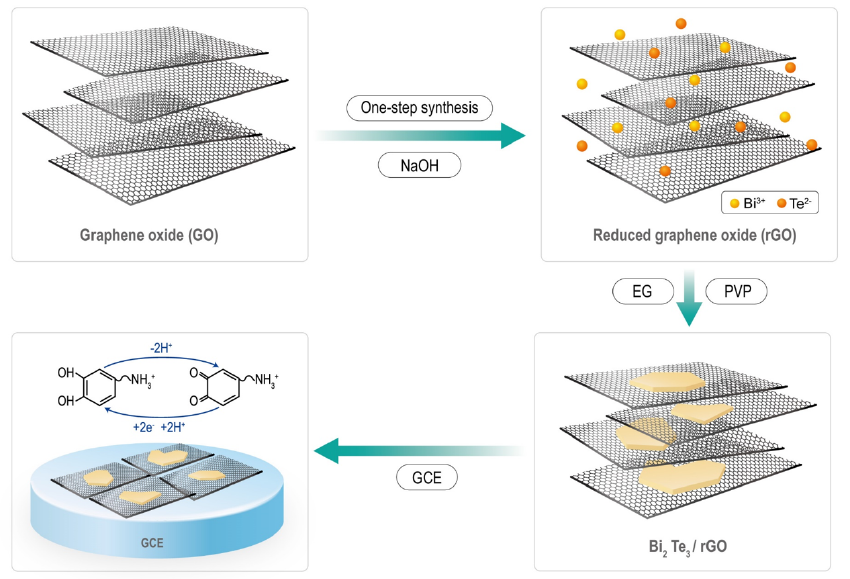
Figure 1. Synthesis of Bi 2 Te 3 (BT)-nanosheet/rGO nanocomposite and the mechanism of electro- chemical dopamine oxidation by the BT/rGO